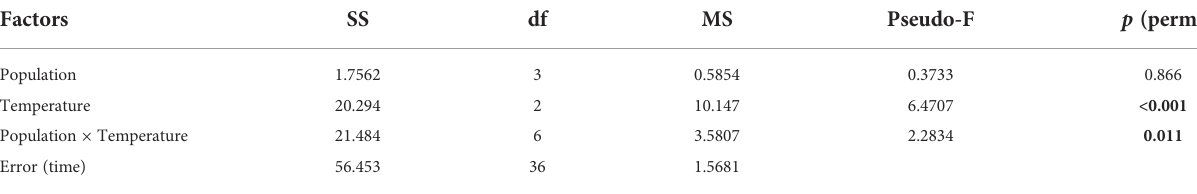
TABLE 5 PERMANOVA for the effects of population and temperature on the number of sporophytes per female gametophytes after 40 days in Laminaria ochroleuca . Factors